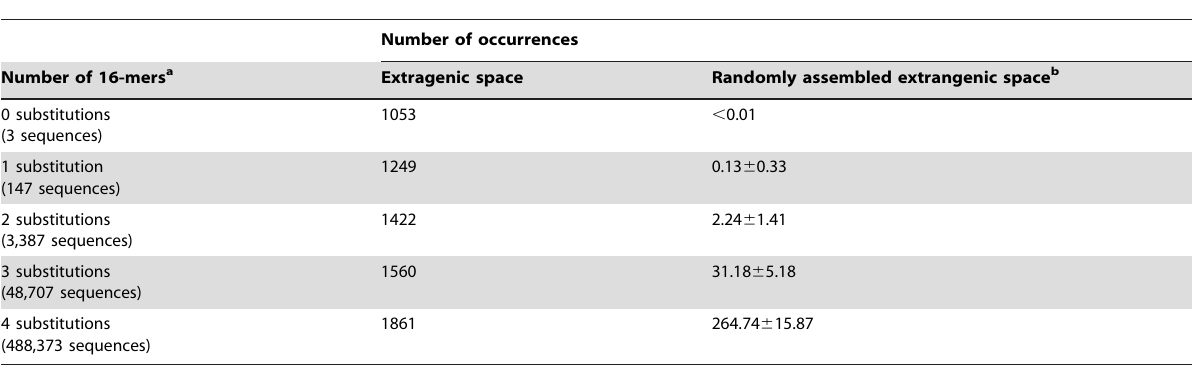
Table 2. Frequency of GI, GII, and GIII 16-mers in the extragenic space of the SBW25